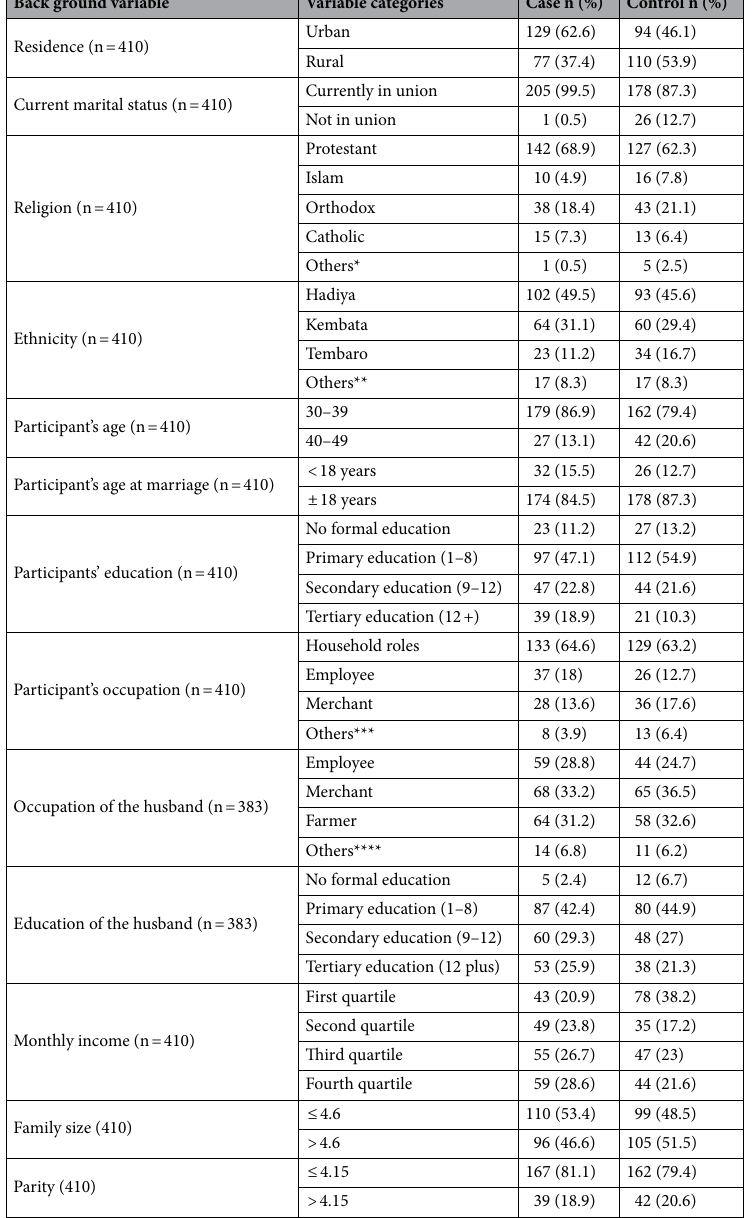
Table 1. Socio-demographic characteristics of study participants in Hadiya and Kembata Tembaro zones, SNNPRG, Ethiopia, October to November 2021. Others* Adventist, Apostolic; Others** Amhara,